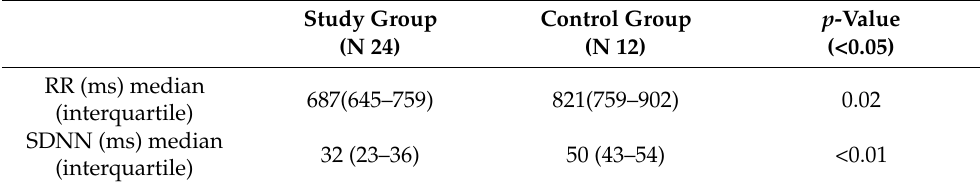
Table 2. Heart rate variability parameters in